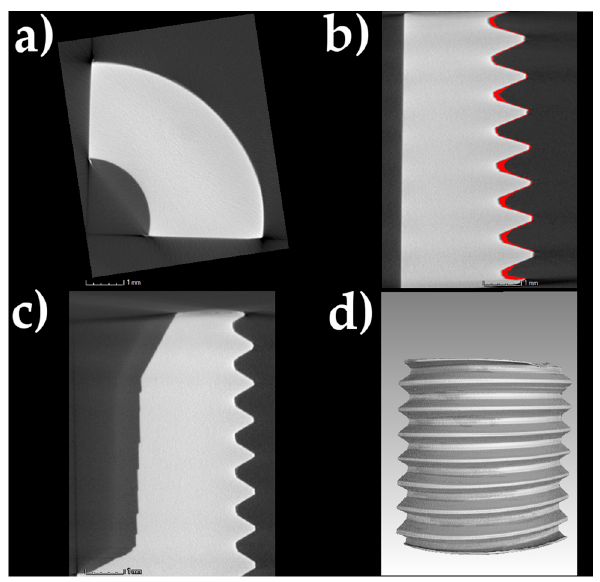
Figure 4. CT images: ( a ) horizontal cross-section with regard to y axis, ( b , c ) vertical cross-sections, ( d ) 3D sample model.